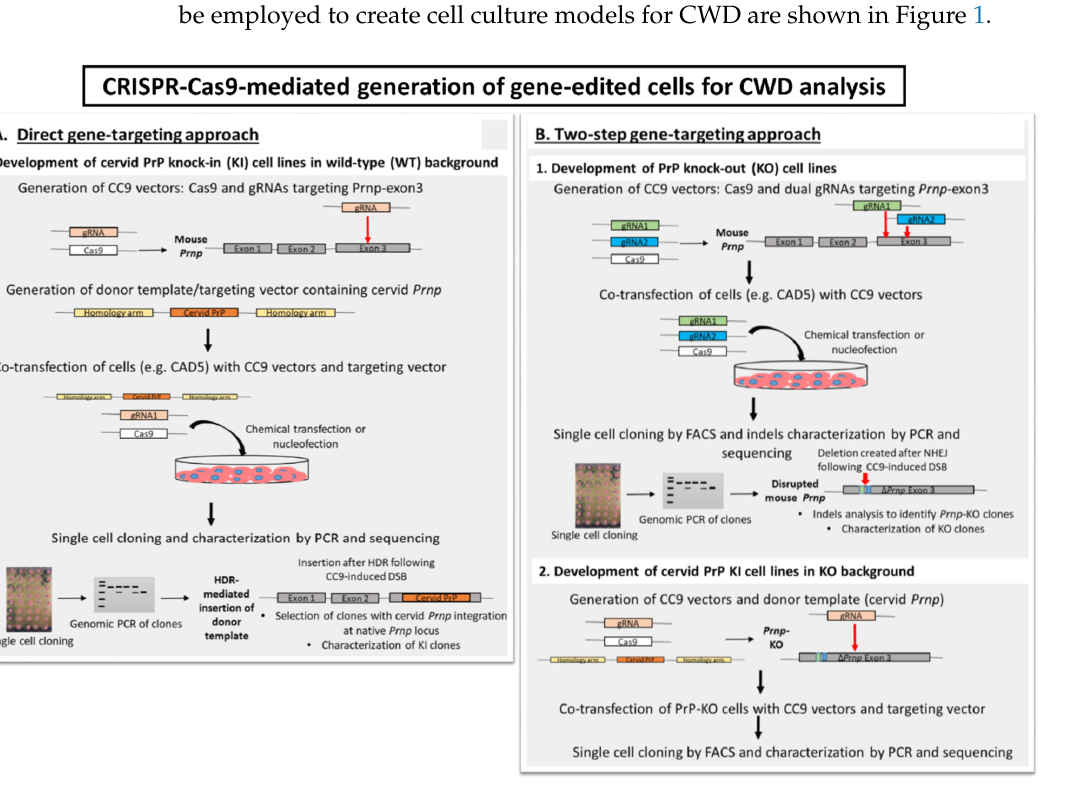
Figure 1. CRISPR-Cas9 (CC9)-based gene-editing for generation of cell culture models to study chronic wasting disease (CWD). Two general CC9 gene-editing approaches can be used to create CWD cell culture models: ( A ) direct gene-targeting/knock-in (KI), and ( B ) two-step gene-targeting involving knock-out of endogenous Prnp followed by knock-in of cervid Prnp at the disrupted Prnp locus. ( A ) Gene-targeting using CC9 in presence of a donor template (cervid Prnp ) results in KI clones where site-specific CC9-induced double-stranded break (DSB) facilitates the